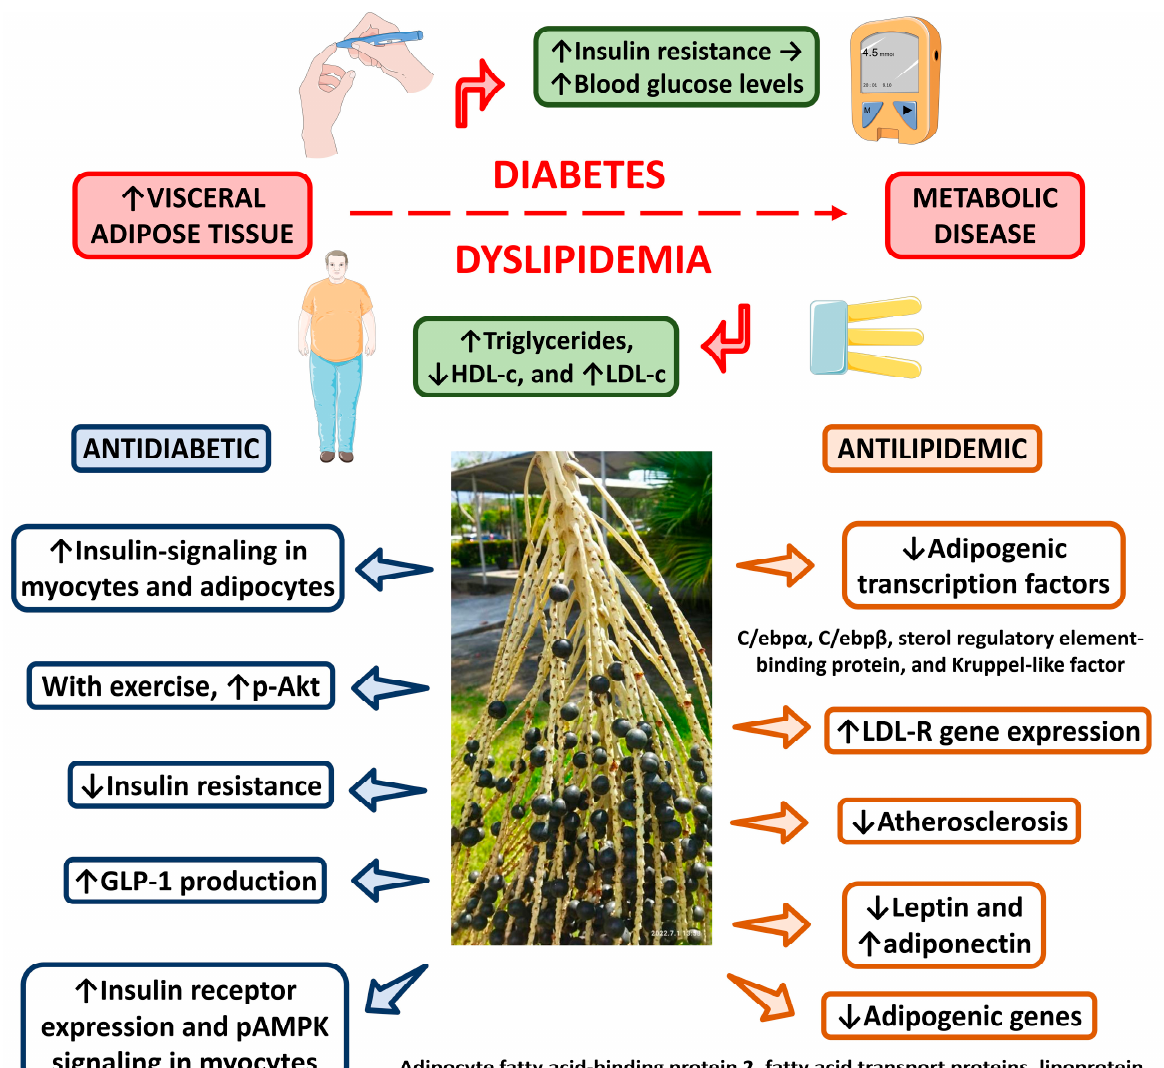
Figure 10. Antidiabetic and antilipidemic effects of açaí. Açaí improves glycemic control and exerts antilipidemic effects via various mechanisms. Symbols and abbreviations: ↑ , increase; ↓ , decrease; GLP ‐ 1, glucagon ‐ like peptide 1; HDL, high ‐ density lipoprotein cholesterol; LDL, low ‐ density lipo ‐ protein cholesterol; LDL ‐ R, low ‐ density lipoprotein cholesterol receptor; Akt, protein kinase B; AMPK, 5 ′ adenosine monophosphate ‐ activated protein kinase.